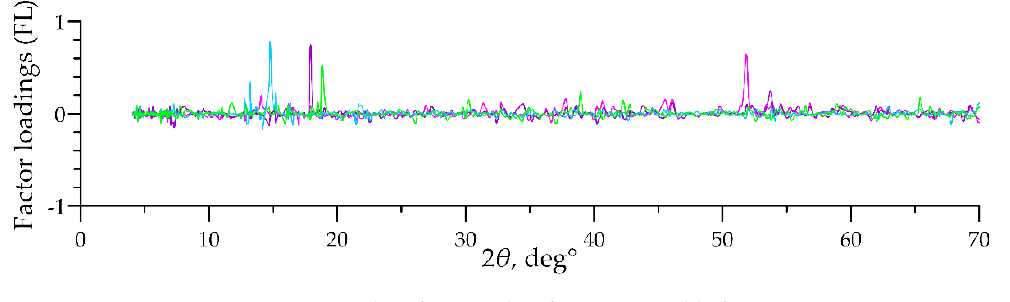
Figure 4. Examples of FL graphs of uninterpretable factors.